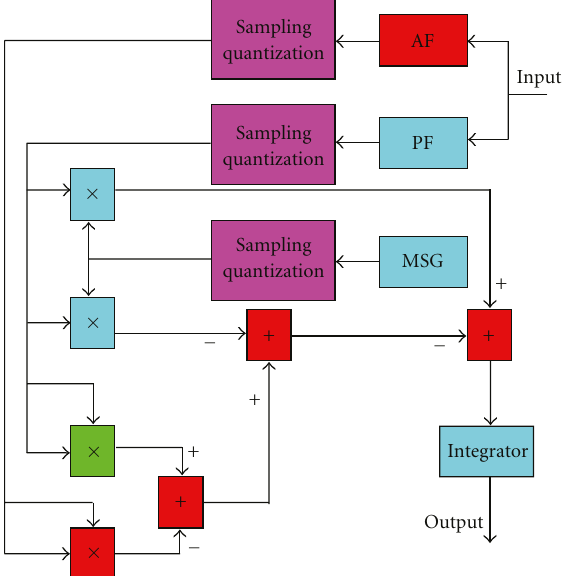
Figure 2: Principal block diagram model of the GR.